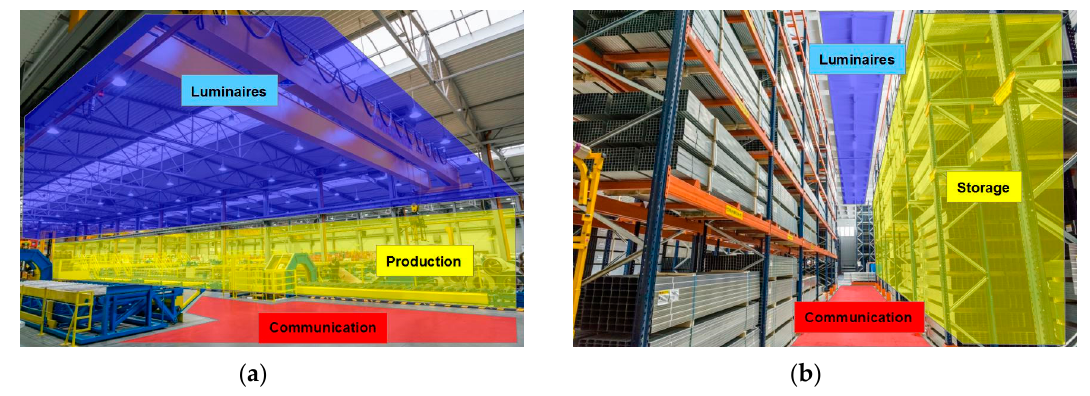
Figure 1. Large useable areas: ( a ) production hall, ( b ) storage hall.